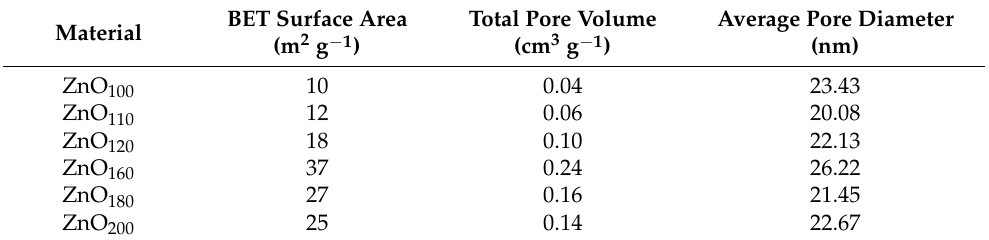
Figure 6. Nitrogen adsorption/desorption isotherms of ZnO x samples, synthesized at various temperatures (100–200 °C), where x subscripts indicate the exact thermal conditions of synthesis. Table 3. Textural parameters of ZnO synthesized in the temperature range of 100–200 °C.